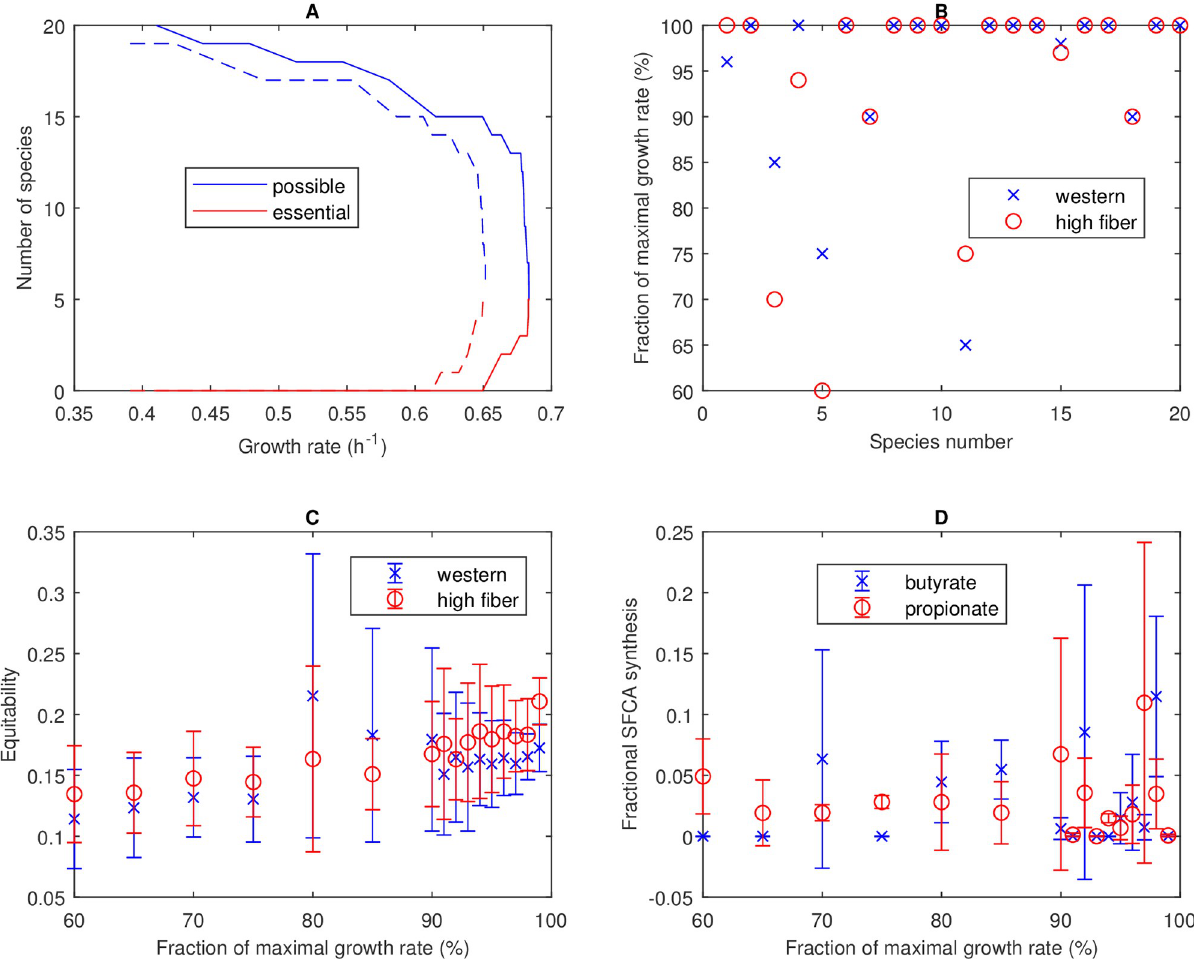
Fig 4. Community FVA performed for the 20-species community with Western and high-fiber diets. (A) Number of possible species and essential species for Western (solid lines) and high-fiber (dashed lines) diets. (B) Growth rate at which the abundance of each species could no longer exceed 1%. (C) Equitability measure D calculated from the 40 FVA solutions at each growth rate. Symbols represent the mean and error bars represent the com standard deviation. (D) Fractional butyrate and propionate synthesis, defined as the synthesis rate of the SCFA divided by the synthesis rate of all SCFAs (acetate, butyrate and propionate), calculated from the 40 FVA solutions at each growth rate for the Western diet. Symbols represent the mean and error bars represent the standard deviation.